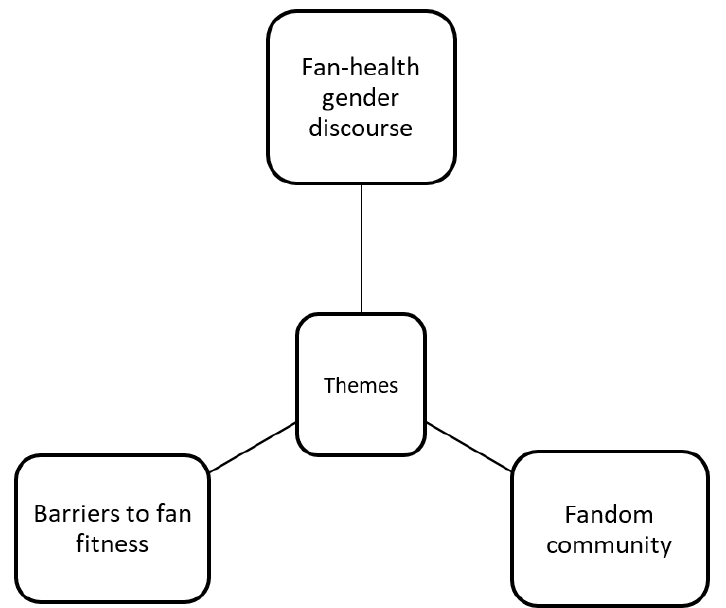
Figure 3. Overview of the three core themes to